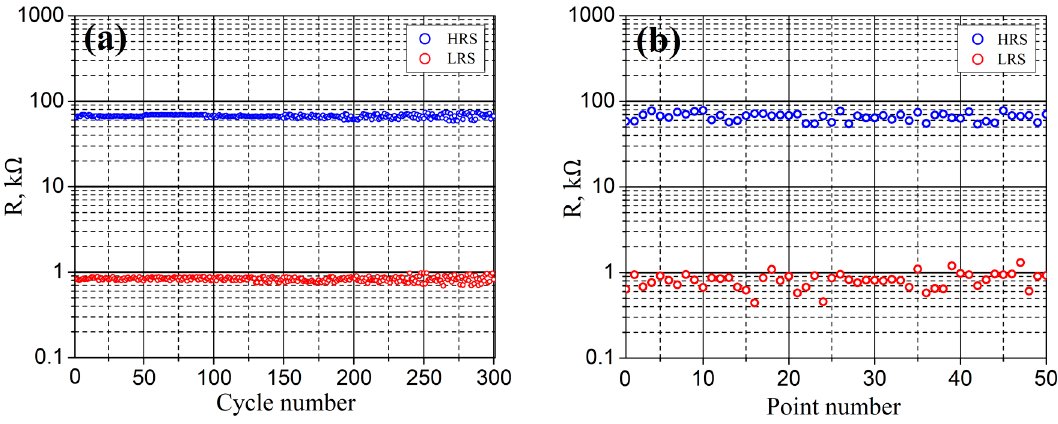
Figure 12. Investigation of resistive switching in electroforming-free nanocrystalline ZnO film: ( a )—uniformity and ( b )—homogeneity.